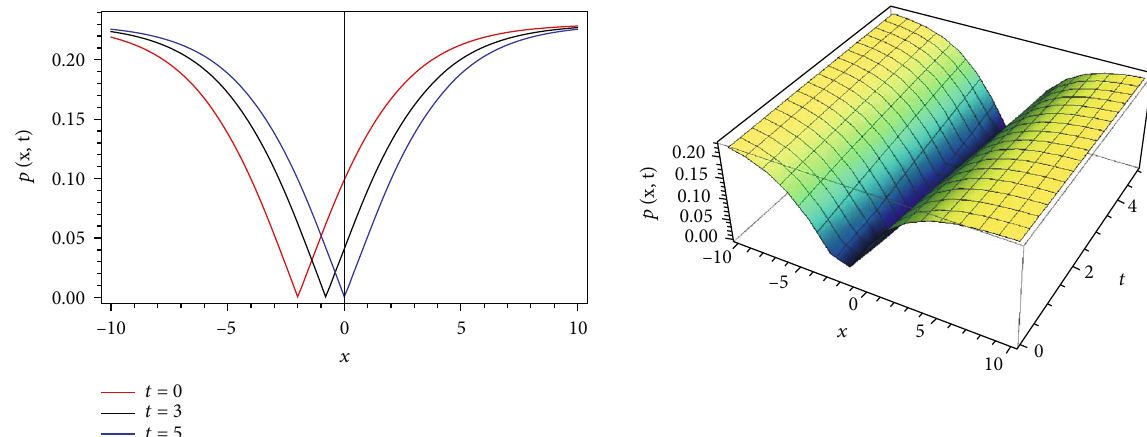
: 1, β : 1, γ : 1, k = 0 : 6, A = 0 : 1, m = 0 : 01, d = 0 : 5, ρ = 0 : 4, δ = 2 j = 0 j = 0 j = 0 0